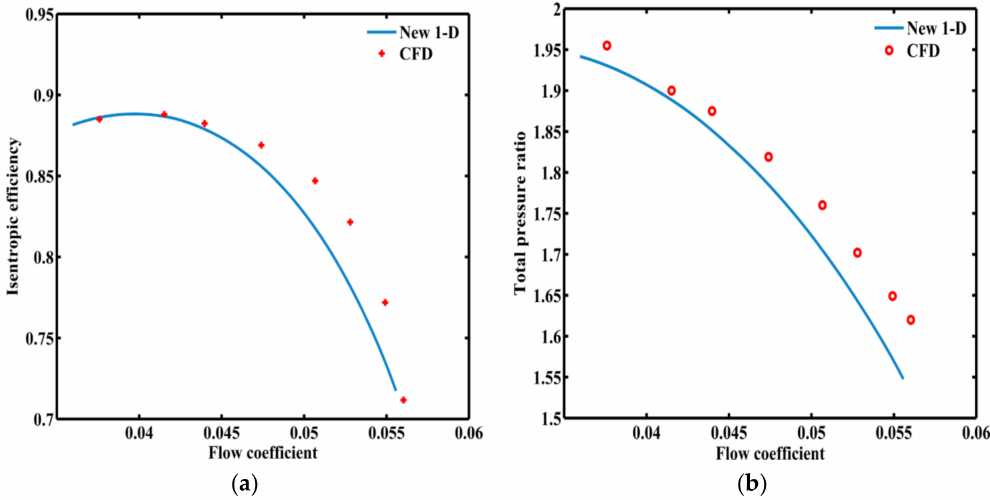
Figure 18. Performance prediction with the new model (10 MWe). ( a ) efficiency; ( b ) pressure ratio.